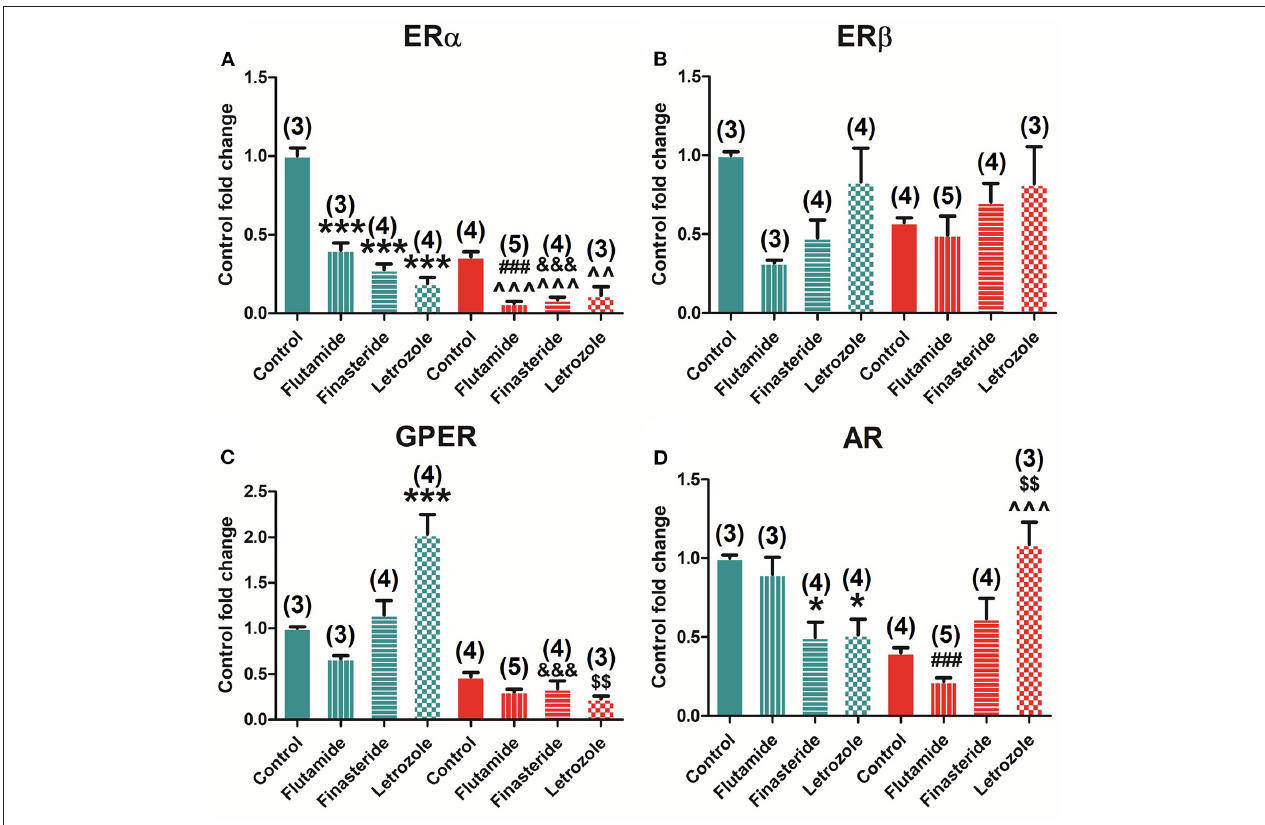
FIGURE 7 | Effect of flutamide, finasteride, and letrozole exposure on ER and AR expression in the adrenal gland in male and female animals. (A) ER α mRNA. (B) ER β mRNA. (C) GPER mRNA. (D) AR mRNA expression levels in male and female animals. Green bars represent males and red bars represent females. Control male ( n = 3), flutamide male ( n = 3), finasteride male ( n = 4), letrozole male ( n = 4), control female ( n = 4), flutamide female ( n = 5), finasteride female ( n = 4), and letrozole female ( n = 3). Data are represented as mean ± SEM. *, ***Significant differences (* p < 0.05, *** p < 0.001) vs. male control values; ∧∧ , ∧∧∧ Significant differences ( ∧∧ p < 0.01, ∧∧∧ p < 0.001) vs. female control values; ### Significant differences ( ### p < 0.001) comparing female flutamide vs. male flutamide values; &&& Significant differences ( &&& p < 0.001) comparing female finasteride vs. male finasteride values; $$ Significant differences ( $$ p < 0.01) comparing female letrozole vs. female letrozole